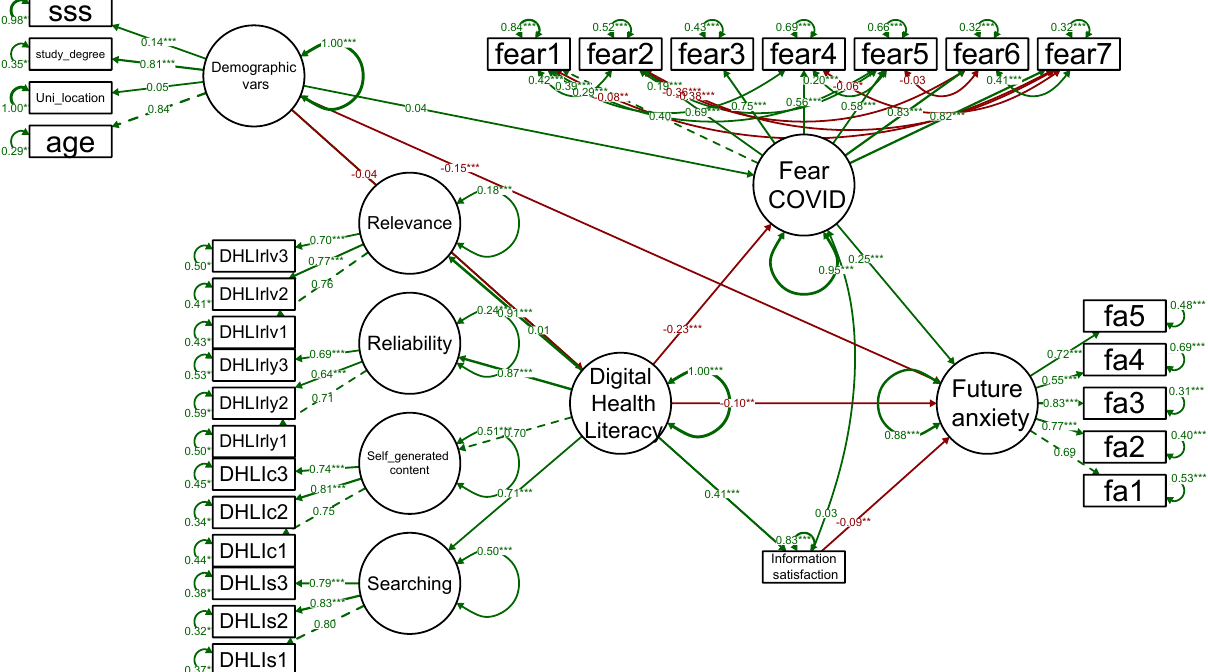
Figure 5. Pathway analysis for digital health literacy, future anxiety, and mediators. Abbreviation: fa—Future anxiety, fear—Fear of COVID-19, DHLIrlv—Subscales of DHL in relevance, DHLIrly— Subscales of DHL in reliability, DHLIc—Subscales of DHL in self-generated contents, DHLIs— Subscales of DHL in searching information, * for p less than 0.05, ** for p less than 0.01, and *** for p less than 0.001, red color text for negative coefficients, green color text for positive 3 AEs for pediatric patients receiving antiangiogenic drugs Figure 1. Proportion of serious/Grade ≥ as monotherapies (drugs assessed in less than 20 patients or not reporting both serious/Grade 3 ≥ AEs).